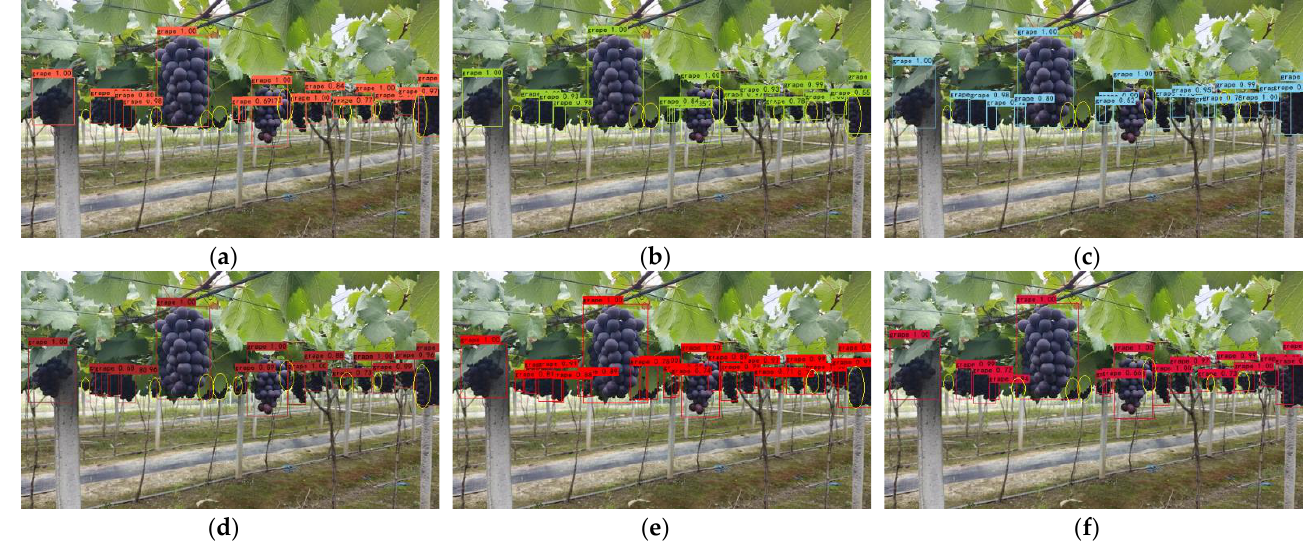
Figure 14. Actual grape detection results of the light network model: ( a ) YOLOv4-MobileNetv1; ( b ) YOLOv4-MobileNetv2; ( c ) YOLOv4-MobileNetv3; ( d ) YOLOv4-tiny; ( e ) GA-YOLO; ( f ) YOLOv5s. The yellow ellipse represents the missed detection of grapes.